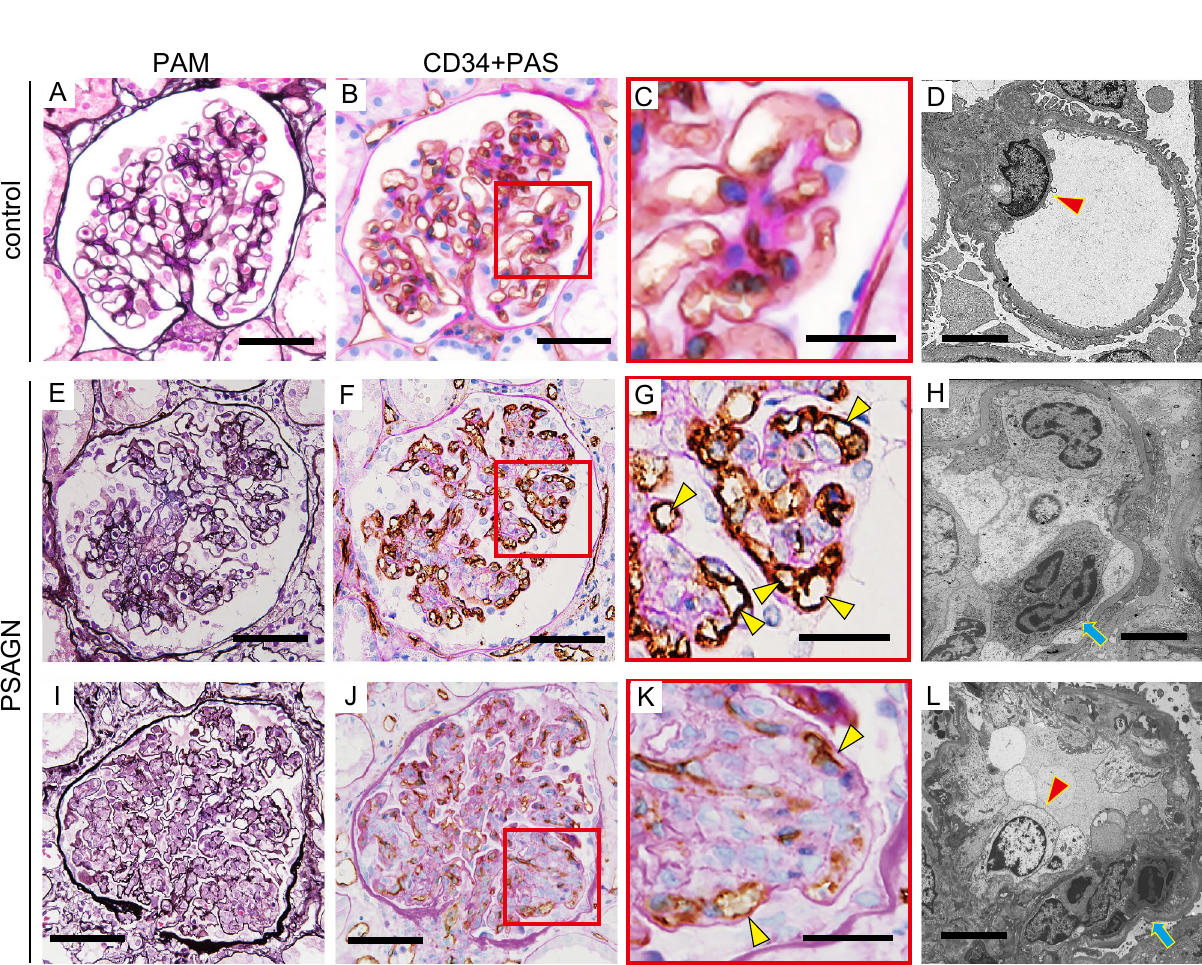
Figure 1. Alteration of the glomerular capillary network by endocapillary proliferation. Representative images of control samples ( A – D ) and PSAGN with mild ( E – H ) and severe ( I – L ) EP lesions. ( A , E , I ) show PAM staining; ( B , C , F , G , J , K ) show CD34 staining with PAS counterstain; and ( D , H , L ) show electron microscopy. Arrowheads indicate endothelial cells ( D , L ). Arrows indicate inflammatory cells ( H , L ). Scale bars, 50 μm ( A , B , E , F , I , J ); 20 μm ( C , G , K ); 5 μm ( D , H , L